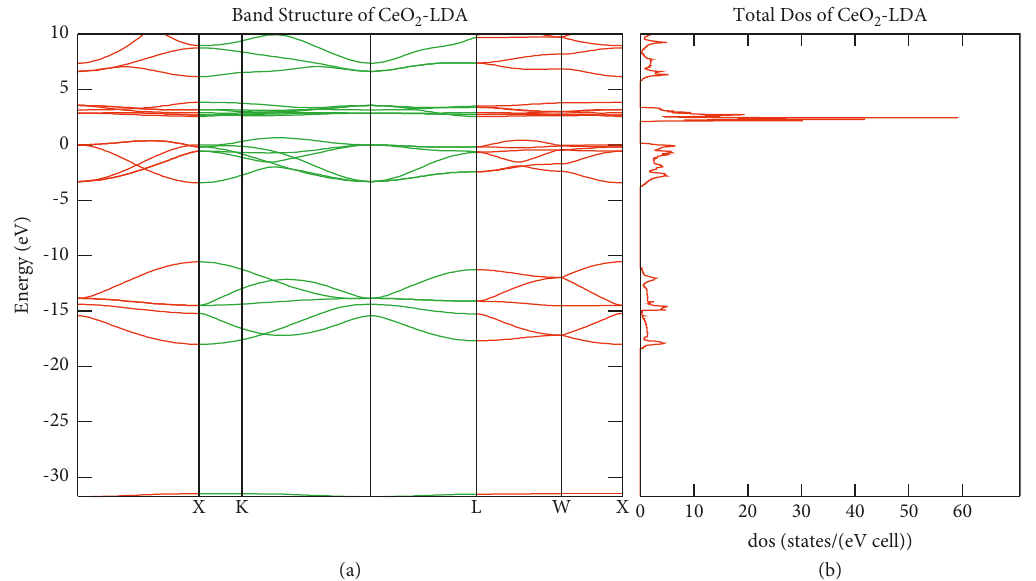
Figure 2: (a) Band structure of CeO 2 and (b) density of states of CeO 2 obtained with LDA.